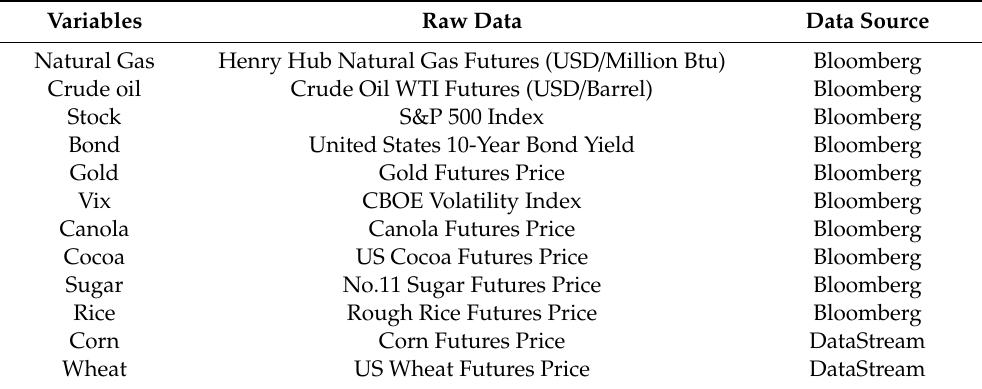
Table 1. Variables in the